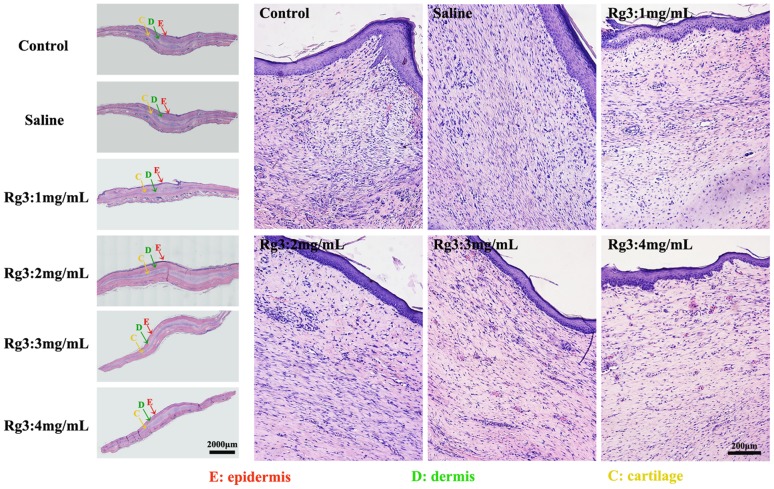
H&E staining of scar hyperplasia on day 28 after wounding.The 1st column shows H&E staining at 40×. The 2–4th columns show H&E staining at 100×. The dermal layer of the untreated control scars and the saline-treated scars were much thicker than Rg3 (1, 2, 3 and 4 mg/mL)-injected groups. The dermal layer was the thinnest in the high concentration Rg3-treated groups (3 and 4 mg/mL).